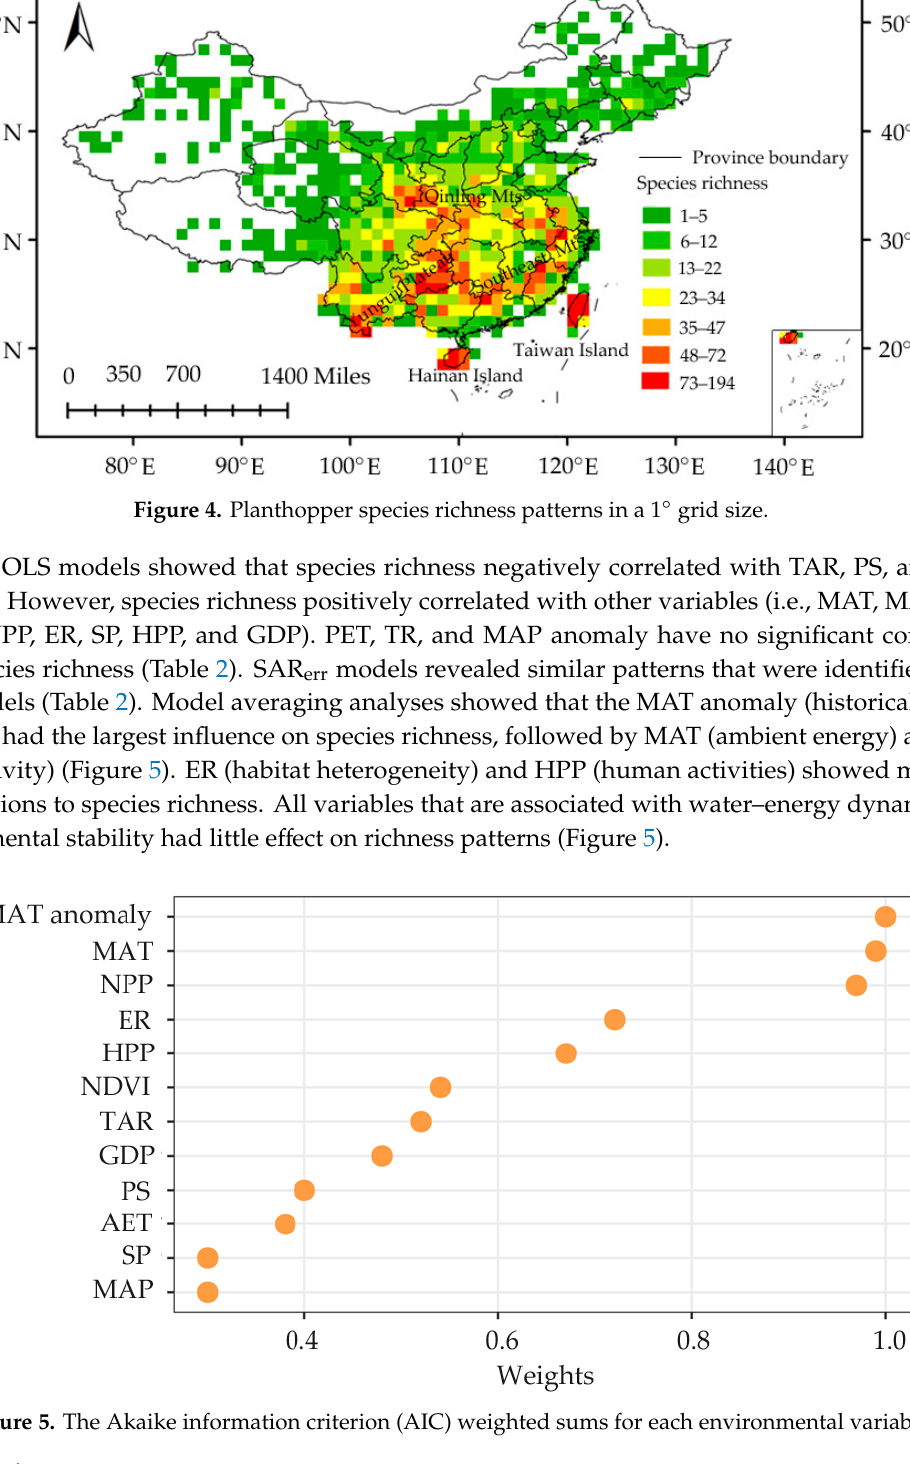
Figure 5. The Akaike information criterion (AIC) weighted sums for each environmental variable.